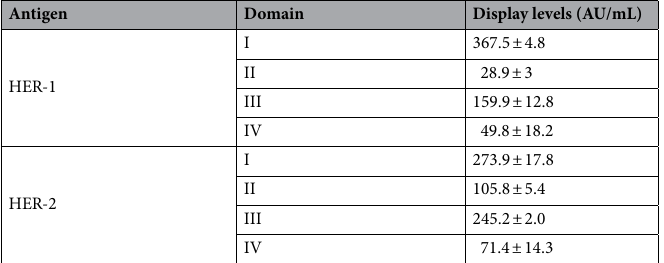
an antibody to the c-myc tag fused to displayed proteins in our system, showed the presence of every individual HER-1/HER-2 domain on phage surface after rescue with M13KO7 helper phage (Fig. 1d,e). As each construct codes for a single polypeptide comprising a signal peptide (removed by signal peptidase from the final protein), the foreign protein to be displayed, the c -myc tag and M13 PVIII, the presence of a reactive tag on phage surface implied that the whole in-frame polypeptide was expressed. Quantitation of the display levels (a composite of the concentration of phage particles and the display levels of foreign protein per viral particle) on the basis of 9E10 binding using a standard curve of phage displaying c-myc tag alone, provided an estimation of the differences between phage preparations (Table 1). Domains II and IV were displayed at lower levels as compared to domains I and III. The difference was more remarkable in the case of HER-1.